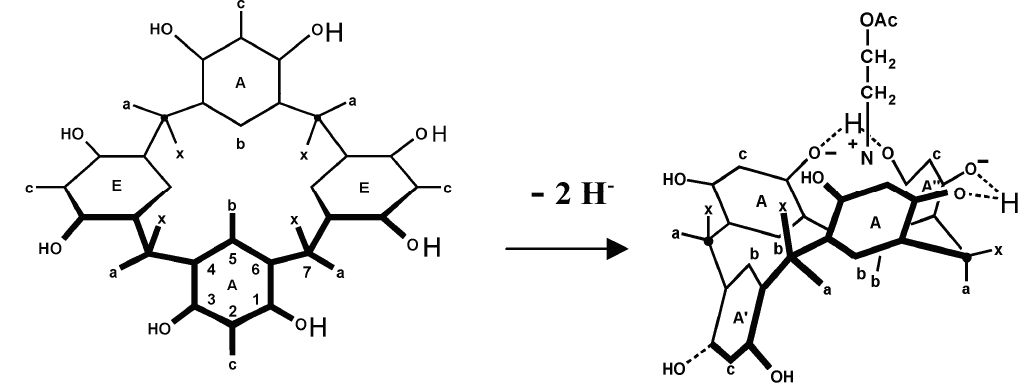
Figure 5. Binding of cholinacetate (Me 3+ N(CH 2 ) 2 OAc) in a resorcarene macrocycle by induced fit (Me groups at + N